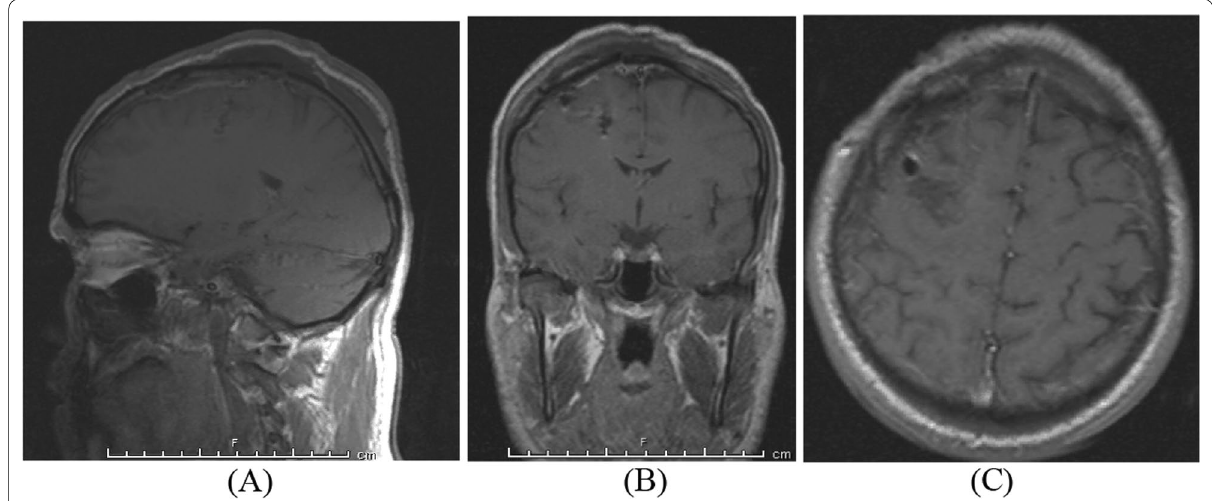
Fig. 15 MRI post‑op of cavernoma case. A sagittal, B coronal, C